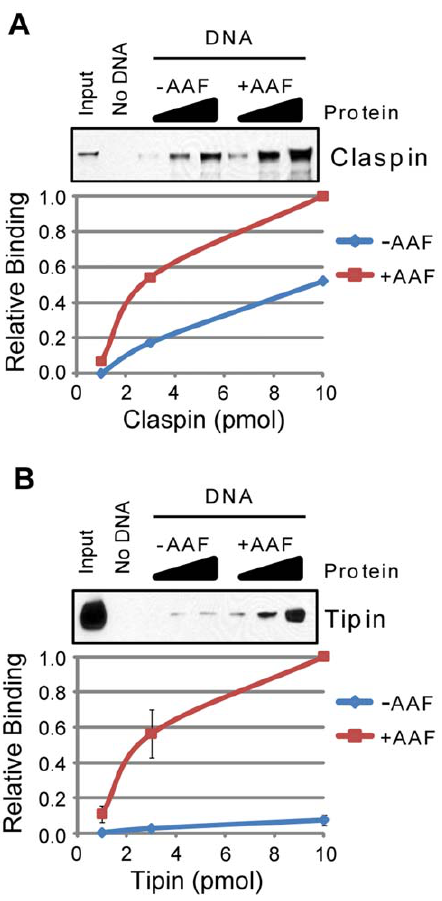
Figure 8. Claspin and Tipin preferentially bind to AAF- damaged DNA. The association of each of the indicated purified proteins with beads alone (No DNA) or to undamaged ( 2 AAF) or N - acetoxy-2-acetylaminofluorene (AAF)-treated ( + AAF) plasmid DNA bound to magnetic beads was analyzed by SDS-PAGE and immuno- blotting. Each of the following proteins was analyzed for binding to each DNA structure: (A) Claspin and (B) Tipin. Reactions were carried out as described in the Methods section.